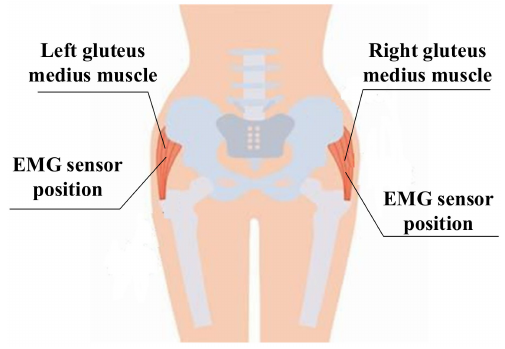
Figure 8. EMG sensor positions at left and right gluteus medius muscles locations.